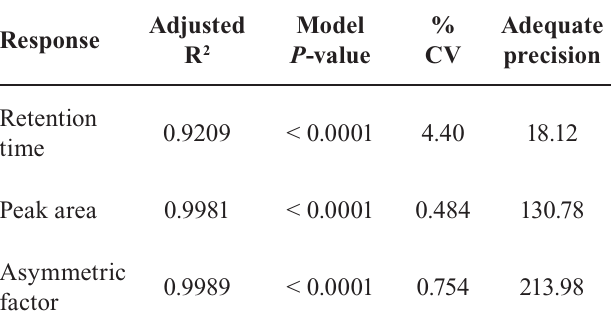
TABLE III - Statistical parameters obtained from